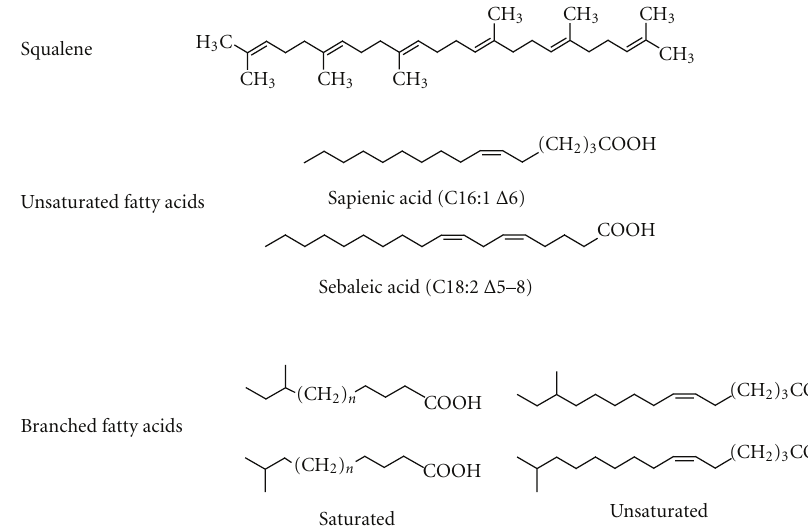
Figure 2: Characteristic components of sebaceous secretion. Squalene is a lipid exclusive of human sebaceous secretion. Among fatty acids, there are some with a peculiar pattern of unsaturation (sapienic and sebaleic acid) and some with a particular chemical structure (branched fatty